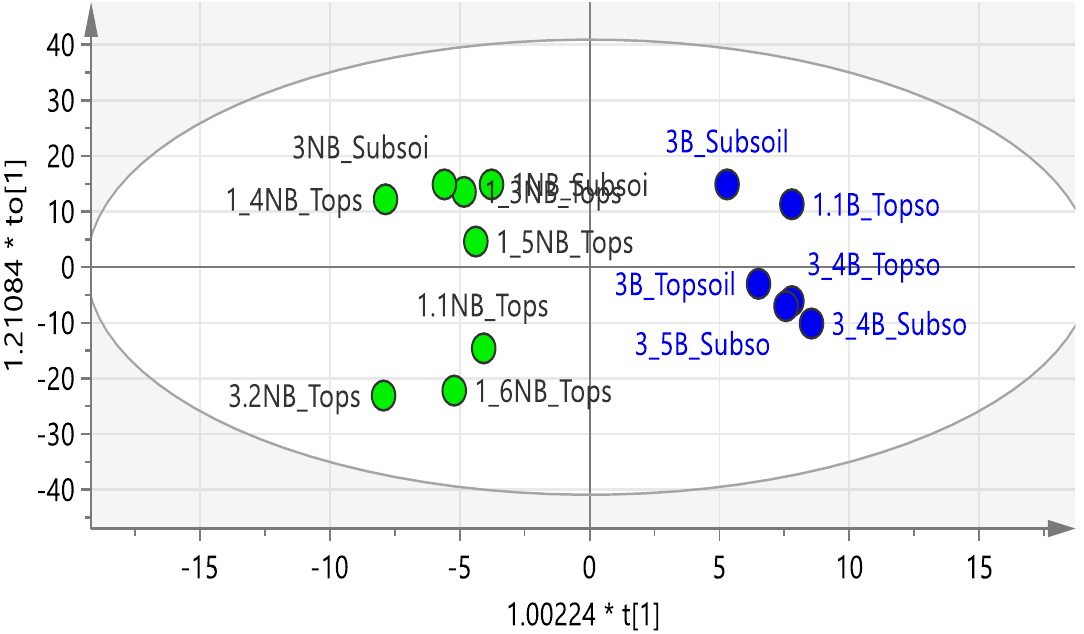
Figure 1. OPLS-DA used as a statistical model to show separation between Burkea (blue) versus non-Burkea (green) top and sub soils (R 2 X = 0.938 and R 2 Y = 0.593).